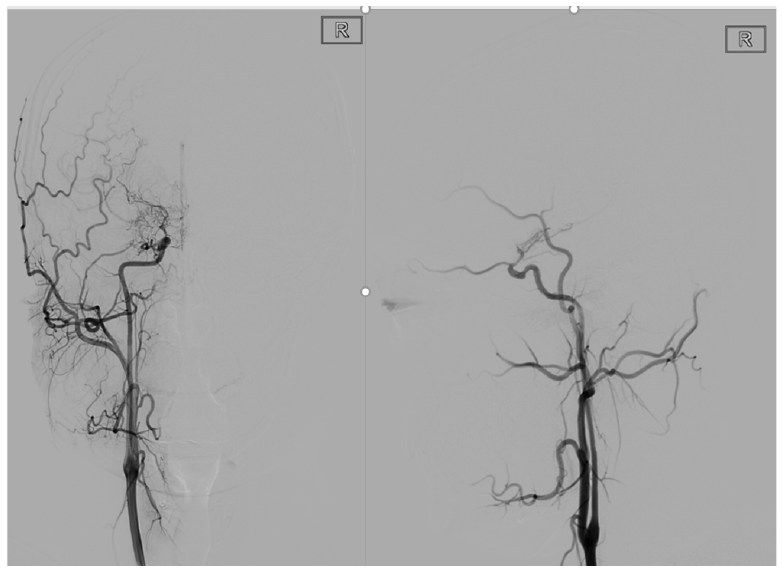
Figure 1. This is a 22-year-old male. These are typical DSA images for MMD. A P-A and lateral view of the internal carotid artery shows occlusion of the right internal carotid artery end with peripheral smoke-like angiogenesis.